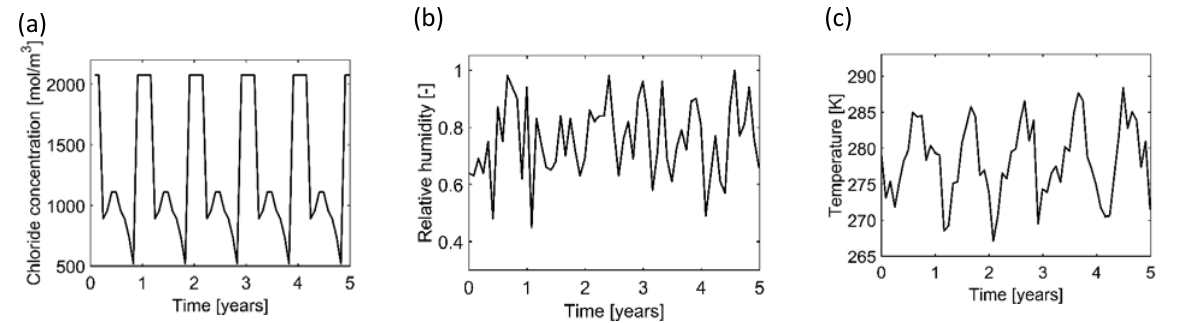
Figure 10. Exposure conditions (a) chloride content, (b) relative humidity, and (c) temperature. Please note: exposure conditions are presented for 5 years only. After